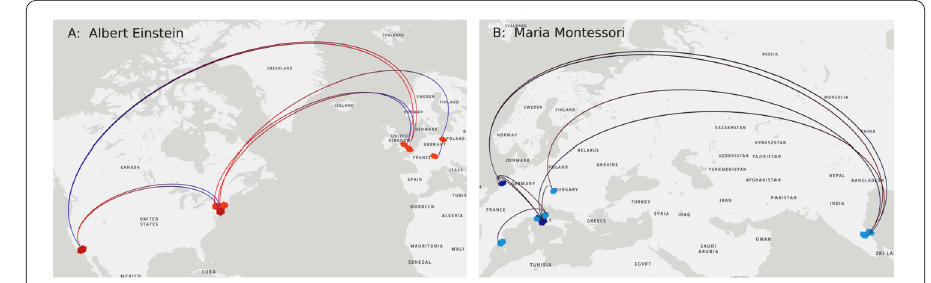
Figure 1 Two examples of the trajectories obtained after the extraction. Panel ( A ) on the left shows the travels made by Albert Einstein while panel ( B ) those made by Maria Montessori